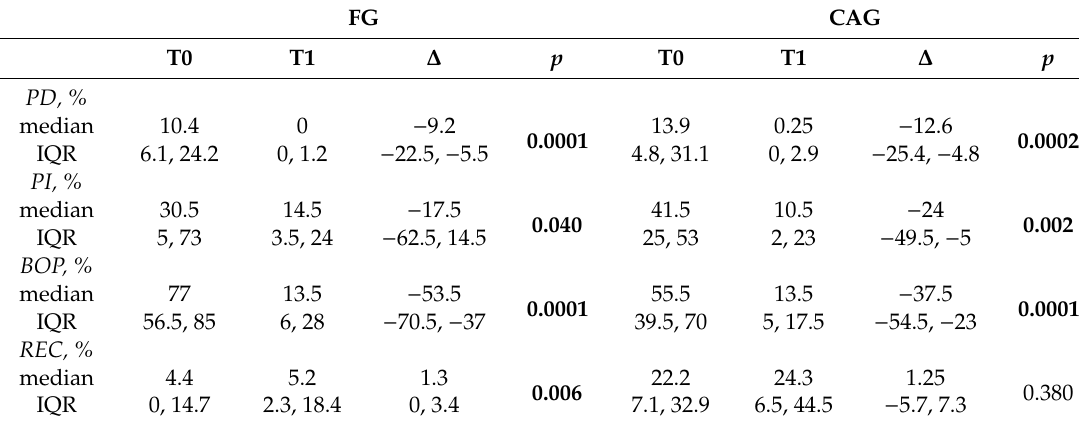
Table 2. Intra-group di ff erences after a 3 month follow-up (T1 −